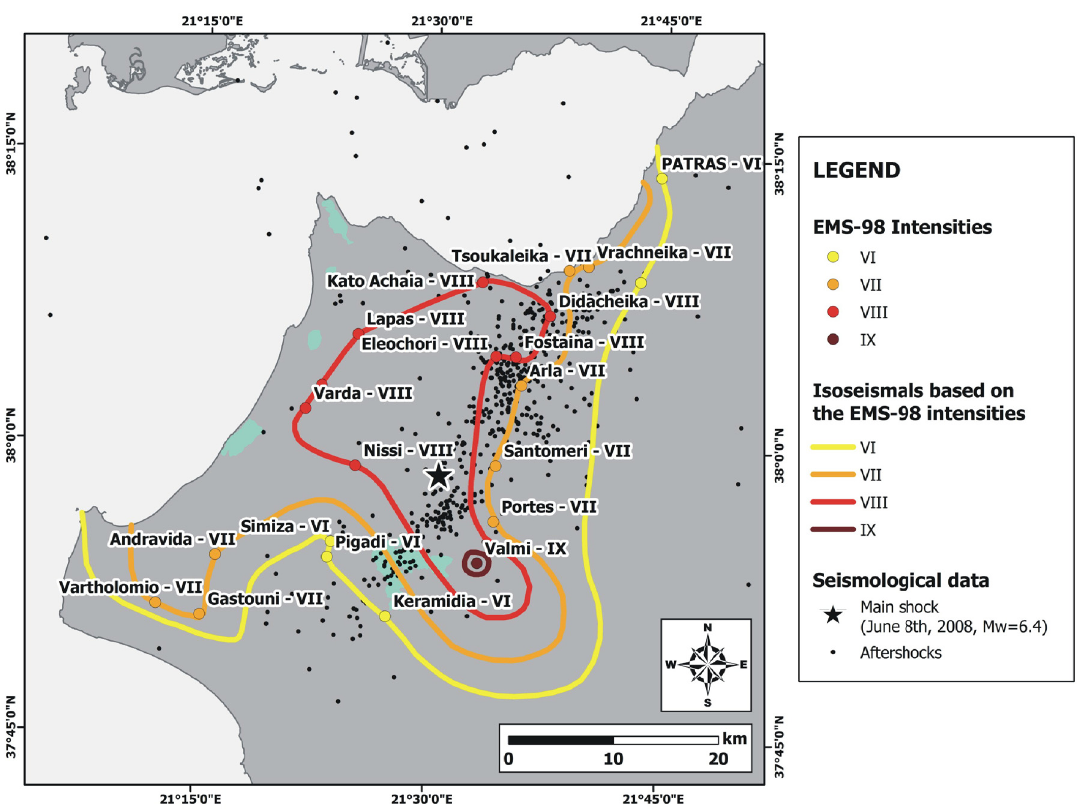
Figure 6. The 2008 Andravida earthquake isoseismal map based on the EMS-98 intensities.